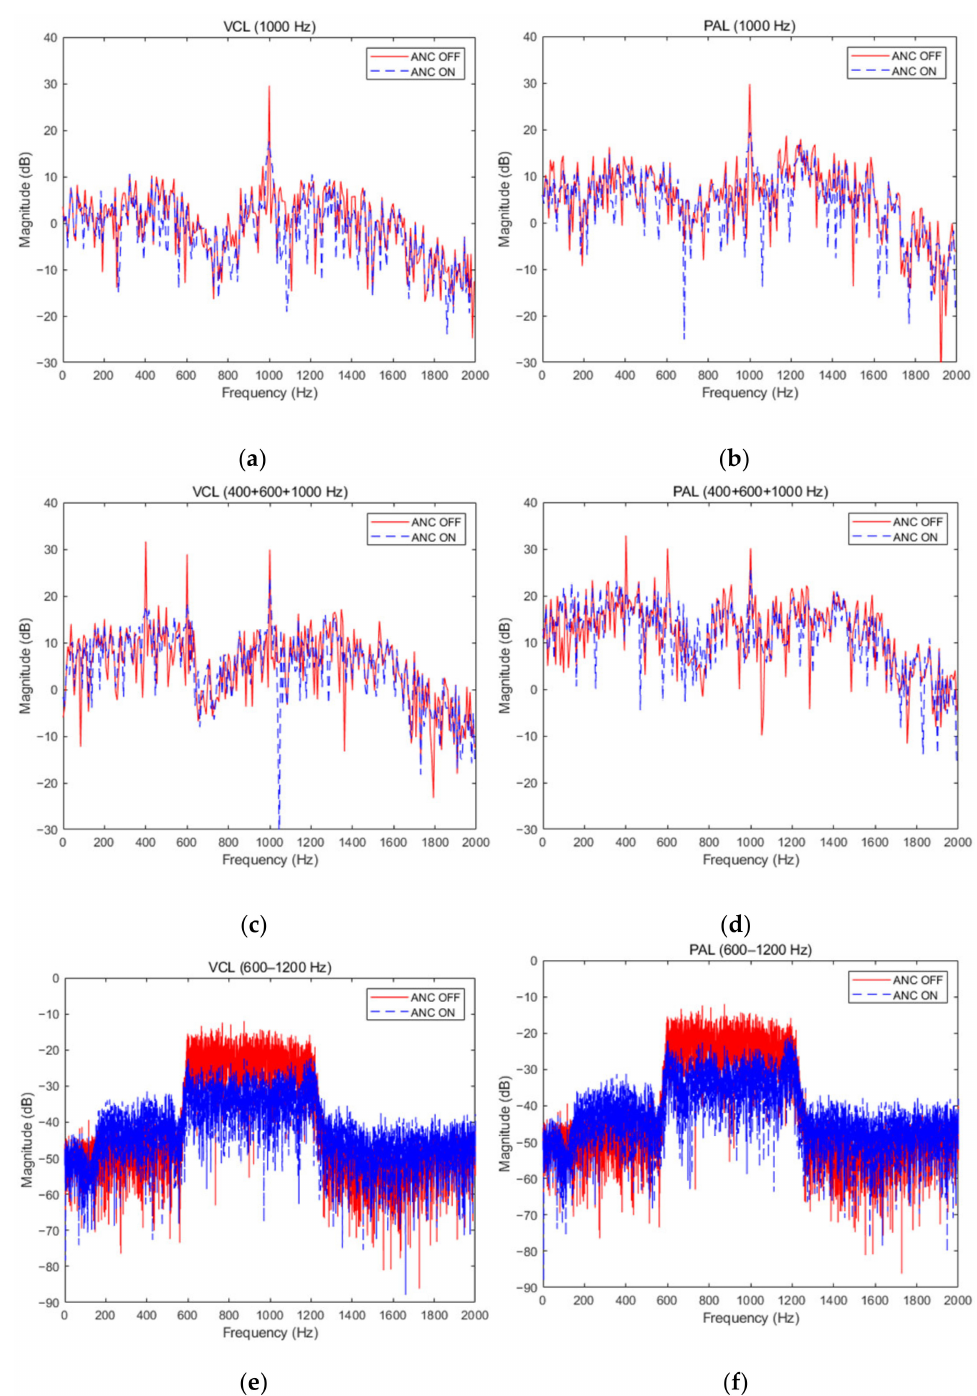
Figure 10. Noise reduction effect of traditional VCL and PAL at single frequency 1000 Hz, multi- frequency (400 Hz + 600 Hz + 1000 Hz) and narrow-band frequency (600 Hz–1200 Hz). ( a ) VCL at 1000 Hz; ( b ) PAL at 1000 Hz; ( c ) VCL at multi-frequency (400 Hz + 600 Hz + 1000 Hz); ( d ) PAL at multi-frequency (400 Hz + 600 Hz + 1000 Hz); ( e ) VCL at narrow-band frequency (600 Hz–1200 Hz); ( f ) PAL at narrow-band frequency (600 Hz–1200